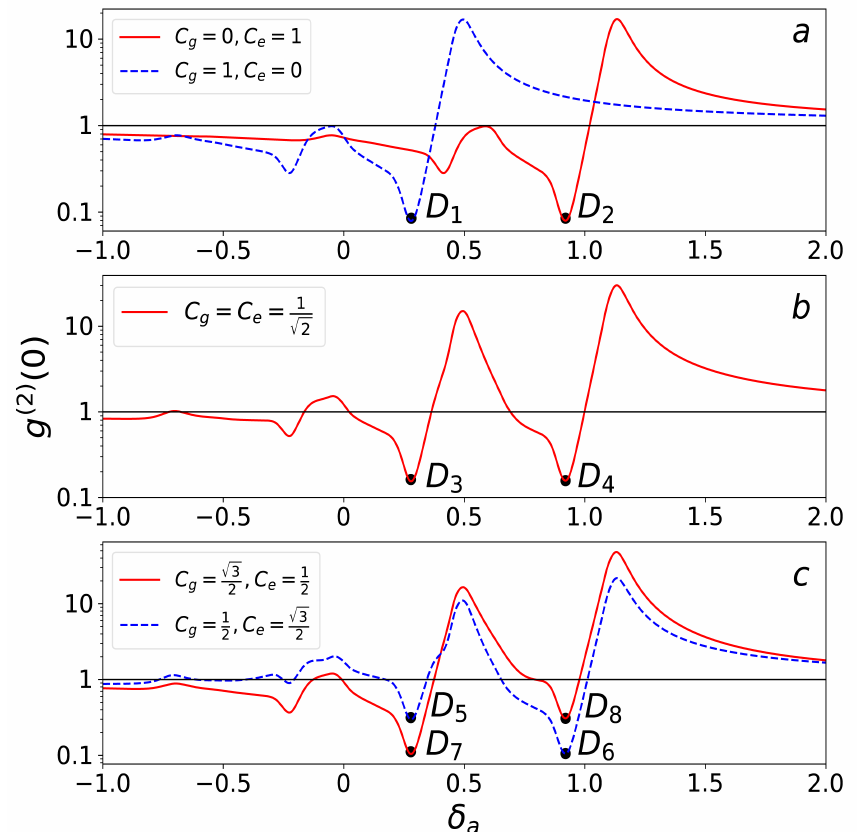
Figure 2. The equal-time SOC function g ( 2 ) ( 0 ) of the cavity field versus the driving detuning δ a for various values of the impurity initial state parameters: ( a ) C g = 0, C e = 1 (red solid line), √ C g = 1, C e = 0 (blue dashed line), ( b ) C g = C e = 1/ 2 (red solid line), and ( c ) C g = √ (red solid line), C g = 1/2, C e = 3/2 (blue dashed line). Other parameters are λ s = 0.5, Ω b = √ = 1, λ = 0.08, λ = 1, ω (cid:48) 2/2, λ iB = 1, η = 0.01, γ c = 0.1 in units of Ω b CB iC i